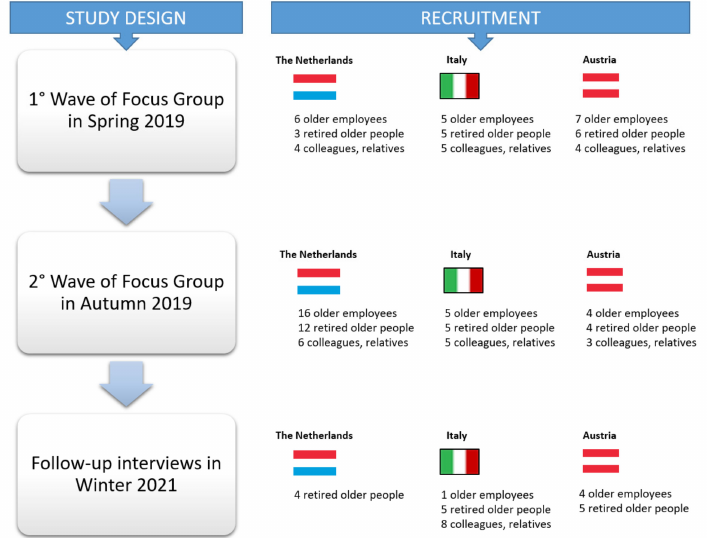
Figure 1. Progress diagram of the data collection